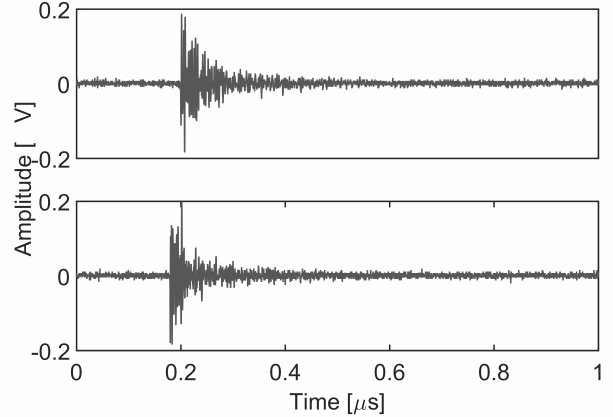
Figure 6. Two characteristic PD signals from the two sources acquired by the antenna 1.